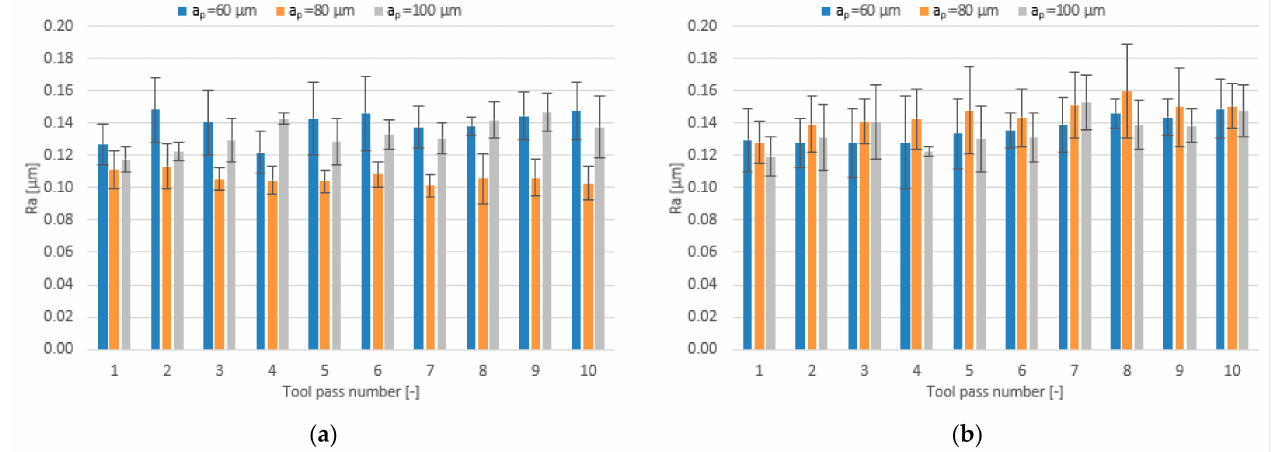
Figure 15. Axial depth of cut a p versus surface roughness parameter Ra in the milling process performed using a tool coated with: ( a ) TiB 2 and ( b ) TiAlN; (v c = 800 m/min; f z = 5 µ m/tooth).